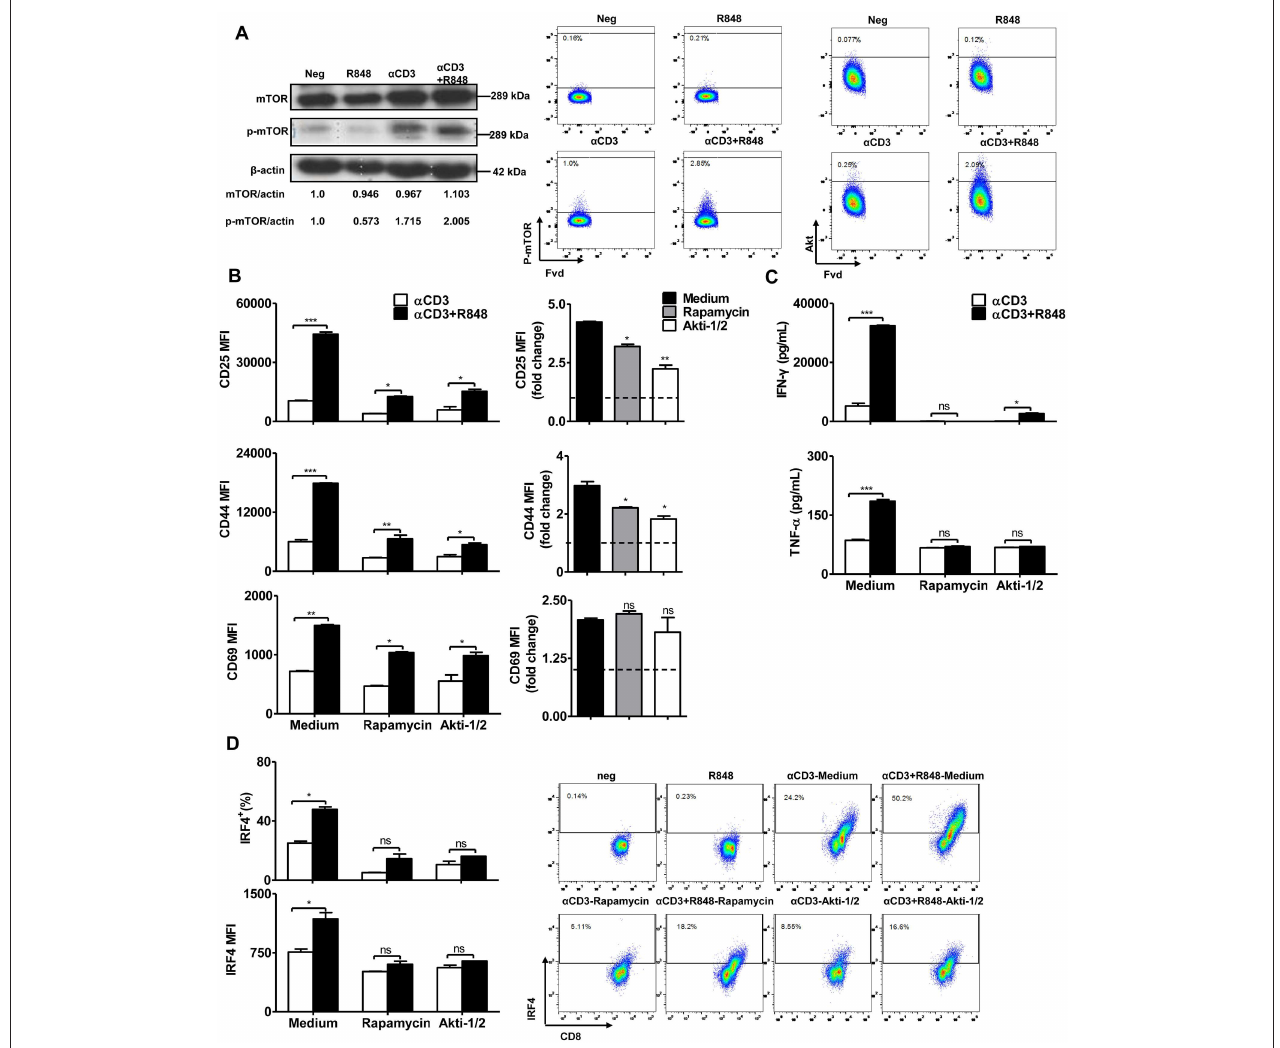
FIGURE 3 | mTOR signaling regulates the effector function of CD8 + T cells. Purified CD8 + T cells were stimulated with α CD3 antibody (5 µ g/mL) with or without R848 (10 µ g/mL) for 48h in the presence of rapamycin (2 µ M) or Akti (1 µ M). (A) mTOR and phosphorylated mTOR in CD8 + T cells were detected by western blotting. The level of phosphorylated mTOR and Akt were further determined by flow cytometry. (B) The activation of CD8 + T cells was assessed by staining with α CD25, α CD44, and α CD69 antibodies. The expression of CD25, CD44, and CD69 in the α CD3 + R848 stimulated cells were expressed as fold changes compared to the α CD3 stimulated cells in the corresponding treatment of rapamycin/Akti-1/2. (C) IFN- γ and TNF- α secretion were detected by specific ELISAs. (D) IRF4 expression was shown by representative dot plots and MFI in CD8 + T cells. Data are representative of three independent experiments. Data are presented as mean ± SD. The statistical relevance was determined by One-way ANOVA ( B , right panel) or Two-way ANOVA ( B , left panel, C,D ): * p < 0.05; ** p < 0.01; *** p < 0.001; ns, not